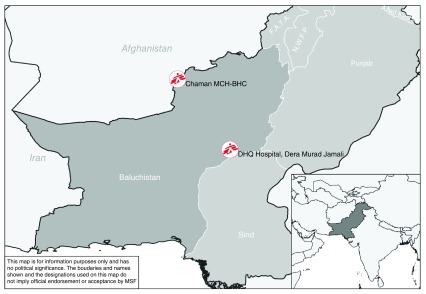
Projects of Médecins Sans Frontières (MSF) in Pakistan.Author: MSF UK Data Source: Natural Earth; MSF